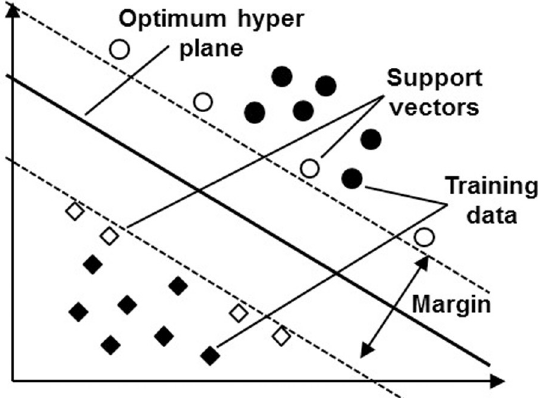
Fig 3. Concept of classification by SVM (unfilled elements represent support vectors while filled elements represent training data).